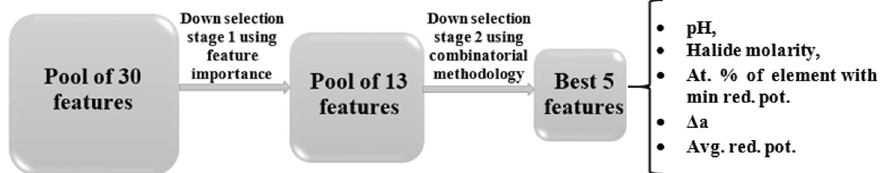
Fig. 1 Schematic diagram of the 2-stage feature down-selection process used in this work to select 5 features from a pool of 30. The 2-stage features down selection process adopted in this work to down select the features from a pool of 30 to a fi nal features, we adopt a 2-stage down selection process as shown in Fig. 1. The fi rst stage down selects top 13 out of the 30 features as obtained from the feature importance function. The second stage of down selection takes all possible combinations of 1, 2, 3, … , 13 features out of the 13 features from stage 1 and evaluates the mean squared error (MSE). The best number and combination of features are thus selected.